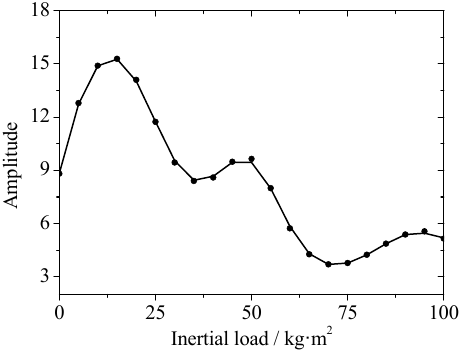
Figure 18. The amplitude of torsional vibration of planetary gears under different inertial loads.